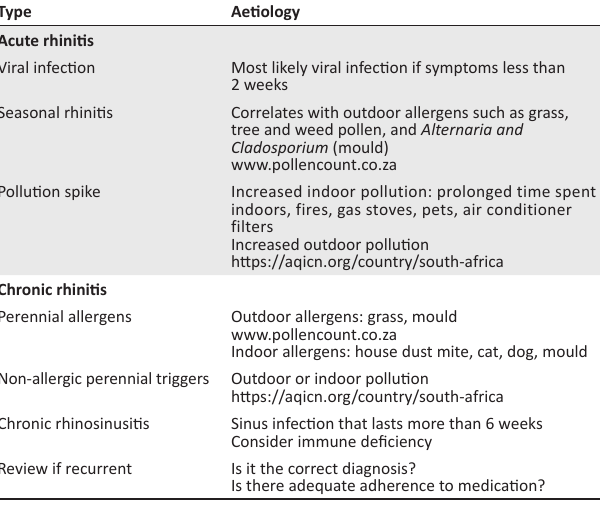
TABLE 1: Distinguishing acute allergic rhinitis